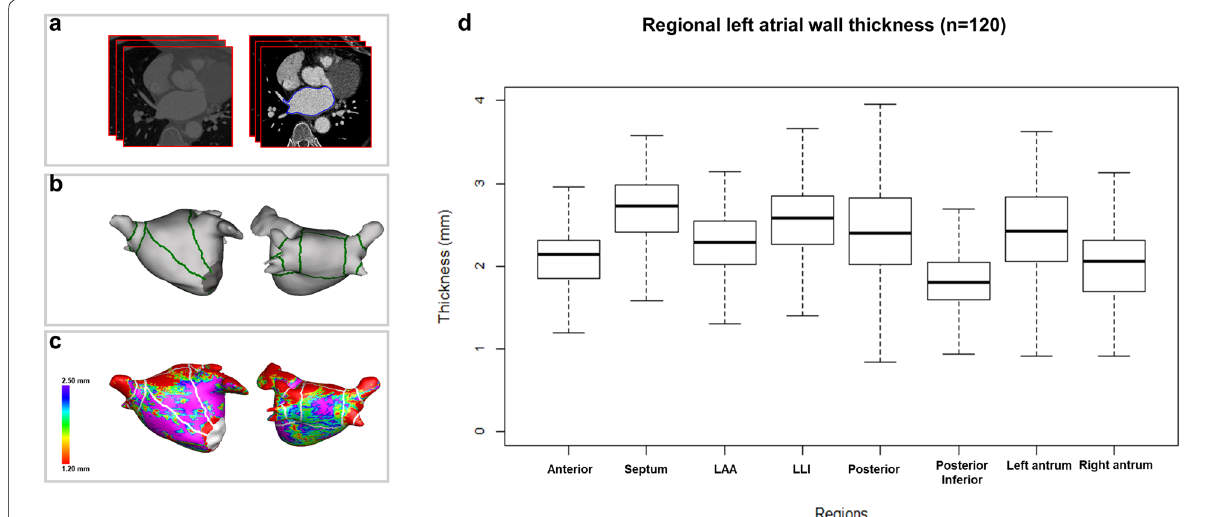
Fig. 4 Comparison analysis with 12 previously published studies. a The cardiac CT of 120 patients. b The mesh of LA segmented into 8 regions. c The LAWT map divided regionally. d The box plot of regional left atrial wall thickness of 120